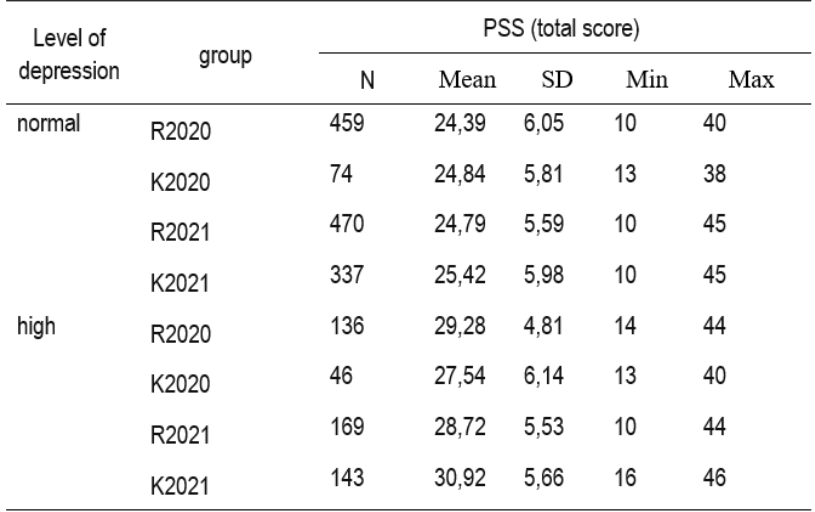
Perceived stress levels in schoolchildren with normal and high depression